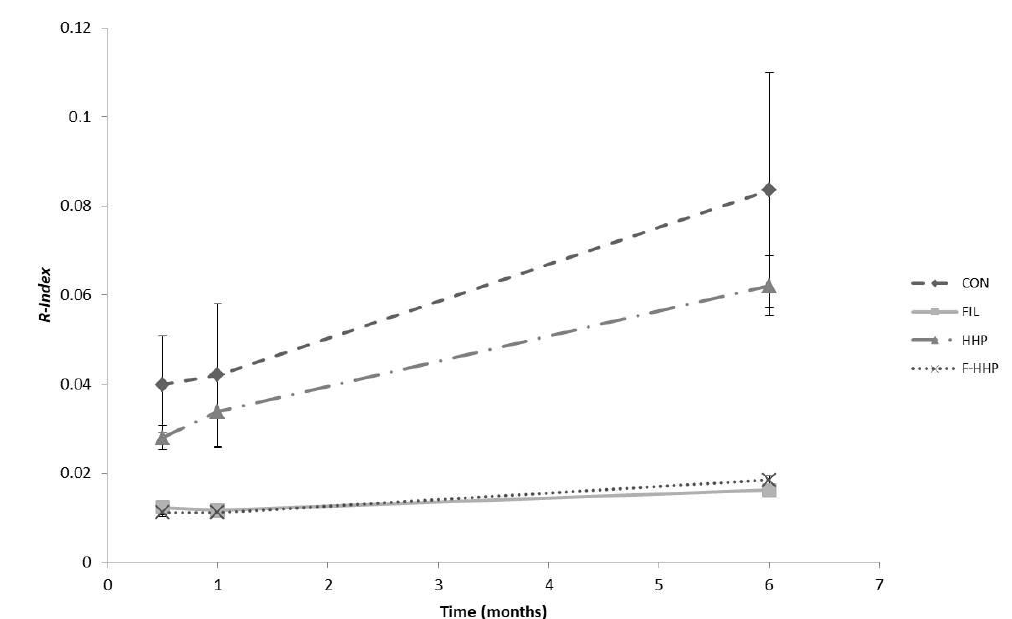
Figure 2. R-index as a function of storage time for the four treatments (CON = veiled and not HHP-treatedoilsamples; HHP = veiledandHHP-treatedoilsamples; FIL = filteredandnotHHP-treated oil samples; F-HHP = filtered and HHP-treated oil samples). Error bars represent the standard